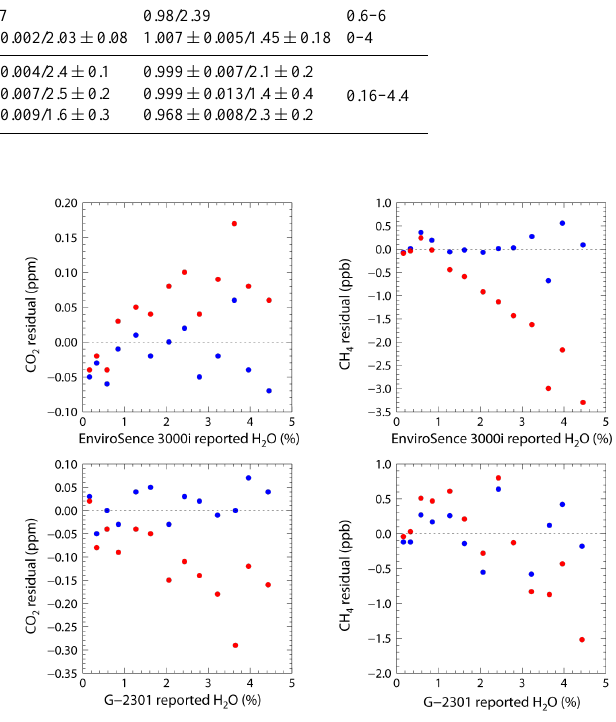
Figure 6. Transferability of water correction function from G-1301 among EnviroSence 3000i and G-2301. Residuals of CO 2 and CH 4 from instrument-specific and G-1301 water correction curve for EnviroSence 3000i and G-2301 are plotted as blue and red plots, respectively against reported water vapor concentration. Residuals from the water correction curve for G-1301 are calculated after the reported water vapor concentrations are collected to that of G-1301 scale with liner correlation.